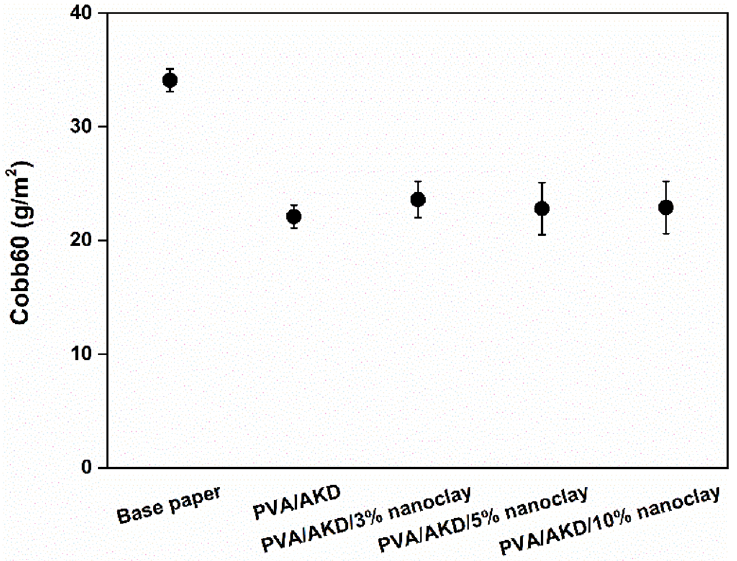
Figure 7. Cobb60 values of the base paper and coated